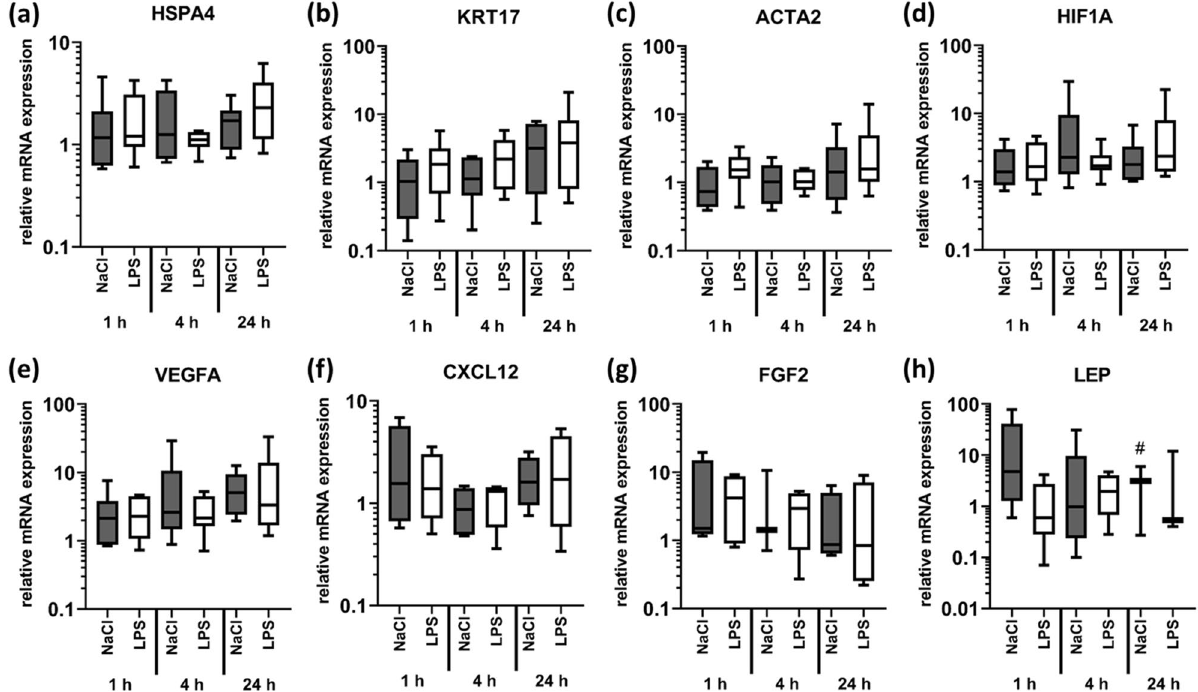
Figure 7. Stimulation with LPS does not alter production of factors involved in heat shock and tissue regeneration responses. LPS (1 µg/ml in 0.9% NaCl; 450 µl/cm 2 ) was injected into the dermis of fresh skin explants to analyse inflammatory processes. NaCl was used as a control for the injection trauma. Biopsies were taken after 1, 4 and 24 h. Relative mRNA expression levels of ( a ) HSPA4 (n = 5), ( b ) CXCL12 (n = 4), ( c ) ACTA2 (n = 5), ( d ) KRT17 (n = 5), ( e ) HIF1A (n = 5), ( f ) VEGFA (n = 5), ( g ) FGF2 (n = 4), ( h ) LEP (n = 5) were determined by RT-qPCR, normalizing target gene expression to the averaged expression of RPLP0 and TBP. Data are presented as median (line) the interquartile range (box) and the minimum and maximum values (whiskers) from 4–5 individual skin explants. p-values < 0.05 were considered as statistically significant with *, **, *** indicating p < 0.05, p < 0.01, and p < 0.001, respectively (dependent on normal distribution ANOVA or Kruskal–Wallis test). For a specific setting, less than three values were detected, indicated by